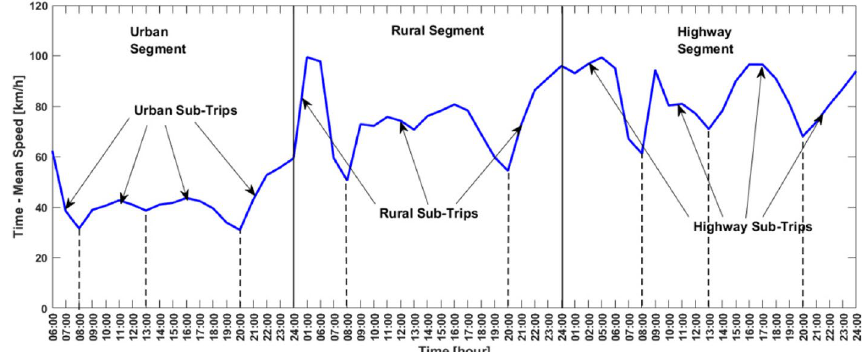
Fig. 3 Time—the mean speed of Istanbul traffic